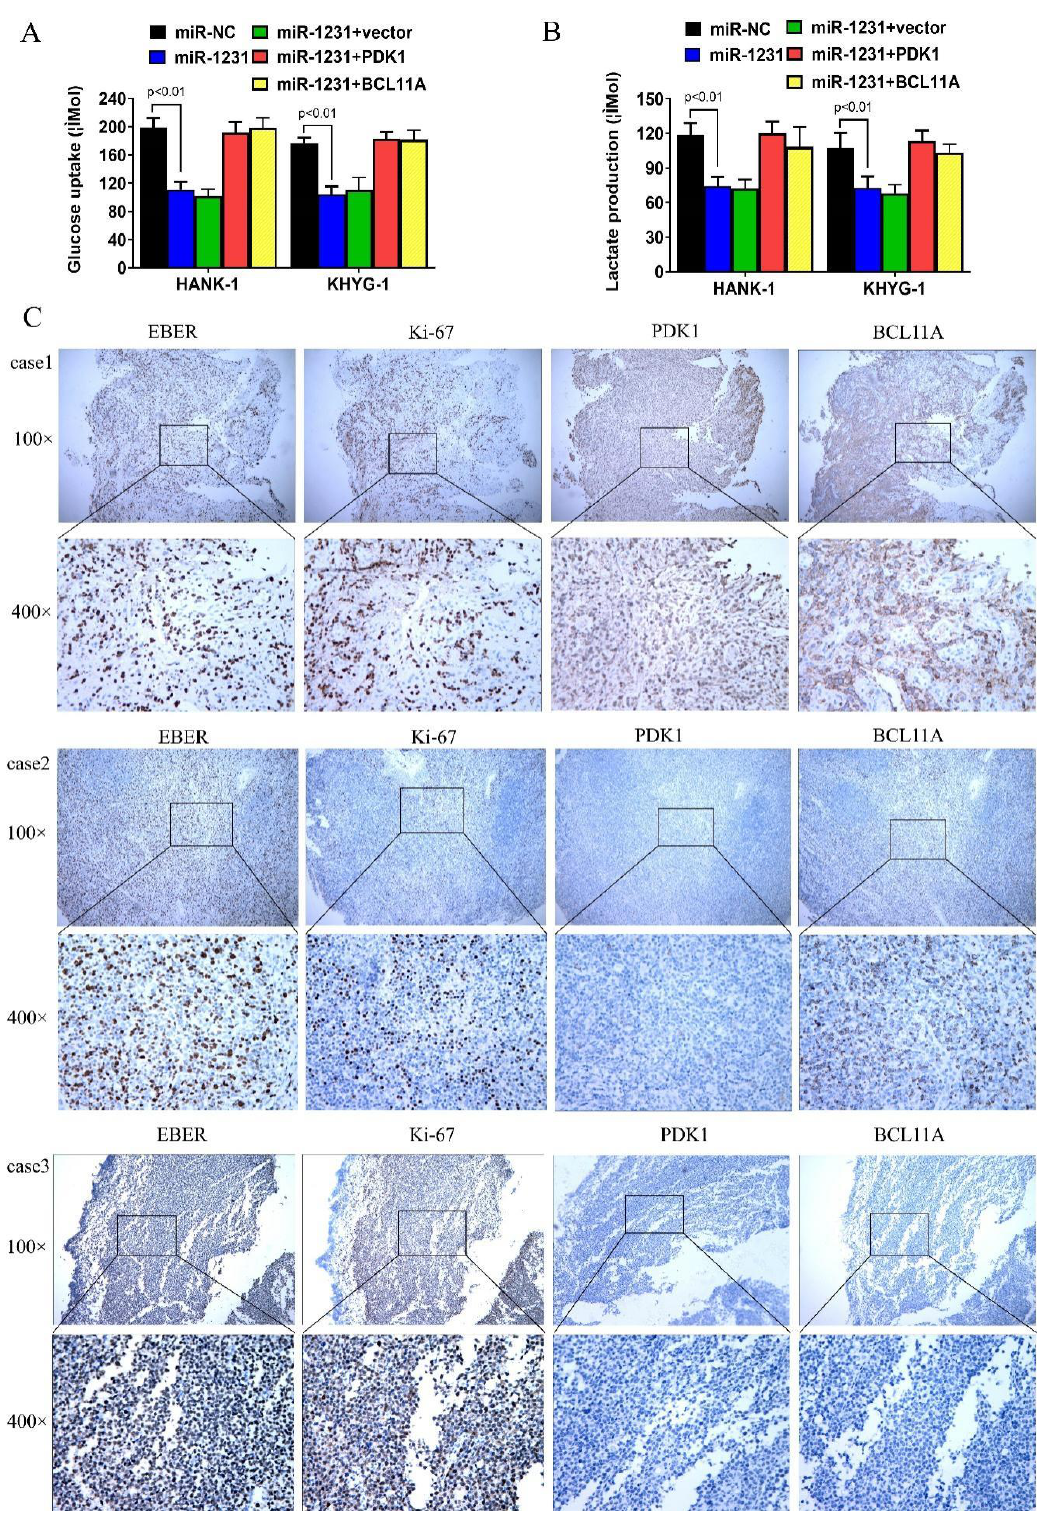
Figure 6. The relationship between miR-1231, BCL11A, PDK1, glucose uptake, and lactate production, and the association between PDK1 and BCL11A protein levels in NKTL. ( A , B ) BCL11A and PDK1 reversed the negative effects of miR-1231 on glucose uptake and lactate production. ( C ) PDK1 and BCL11A protein levels in NKTL. Case 1 was strongly positive for BCL11A and PDK1. Case 2 was weakly positive for BCL11A and PDK1. Case 3 was negative for BCL11A and PDK1. All cases were strongly positive for EBER and Ki-67.